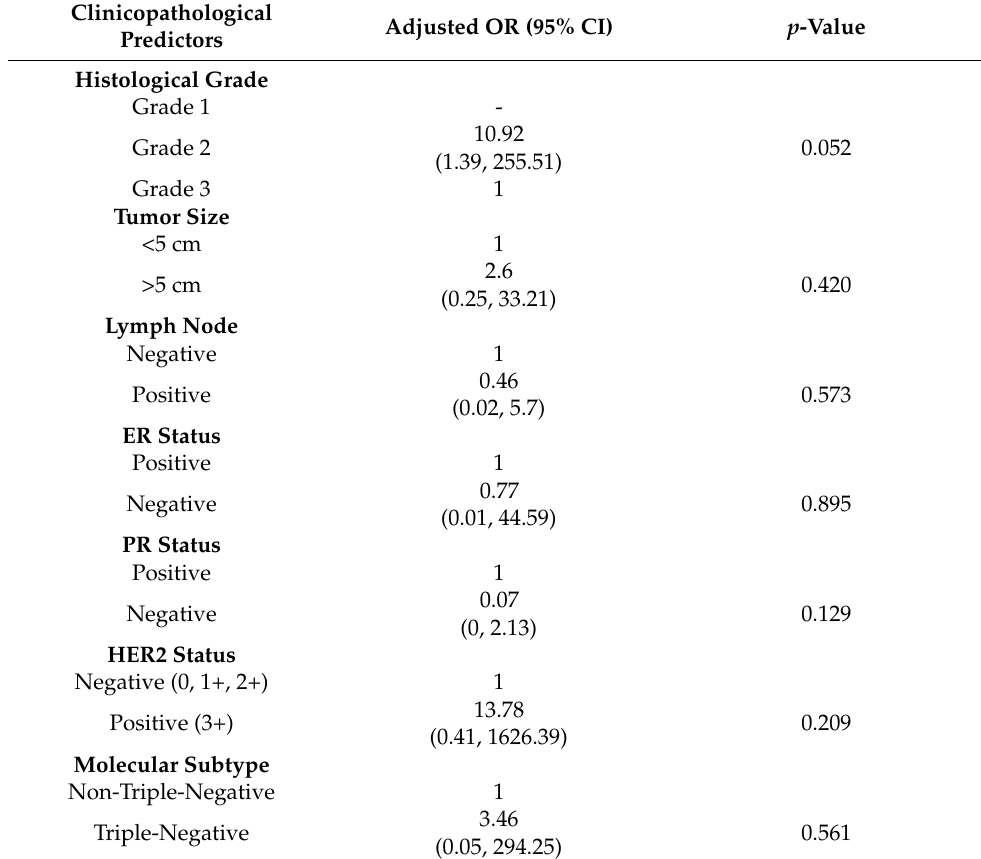
Table 9. Multiple logistic regression analysis of the clinicopathological predictors of IGF-1 expression ( n =